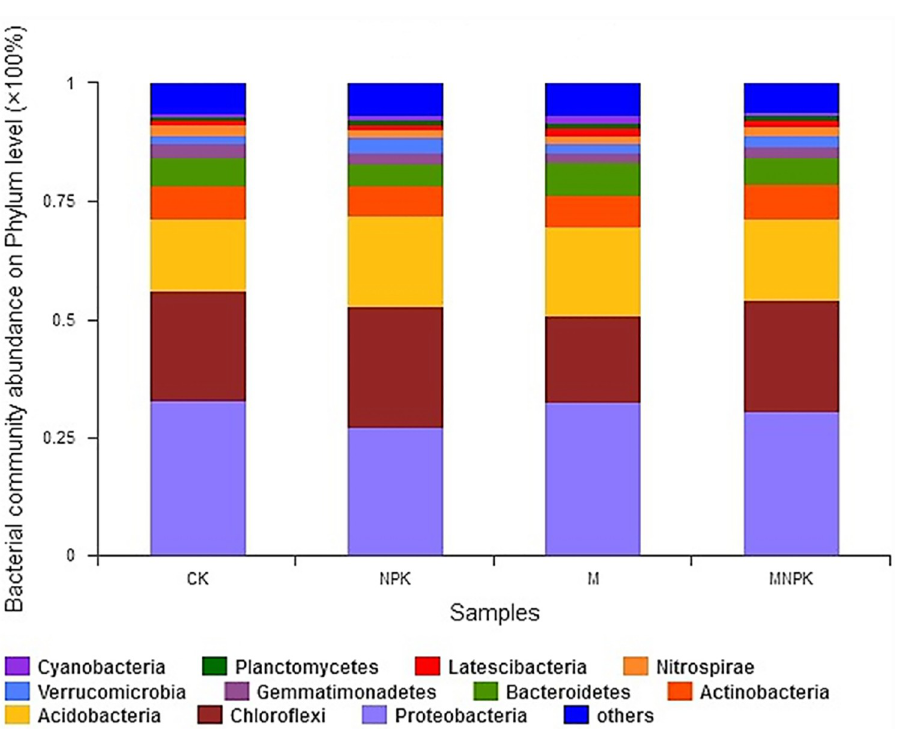
Fig 3. Bacterial community composition on the Phylum level. The % abundances of different bacterial phyla in each treatment group are shown in different colors.